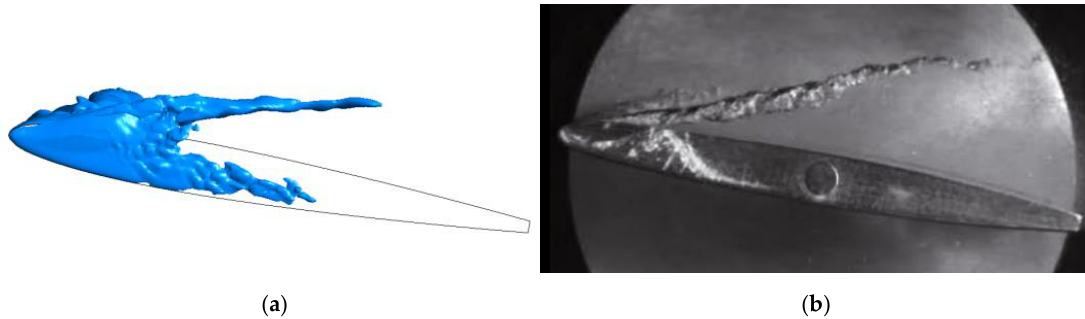
Figure 5. Qualitative comparison of cavitation patterns: ( a ) vapor fraction iso-surface of α v = 0.1 predicted by the present LES, and ( b ) cavitation in the experiment.